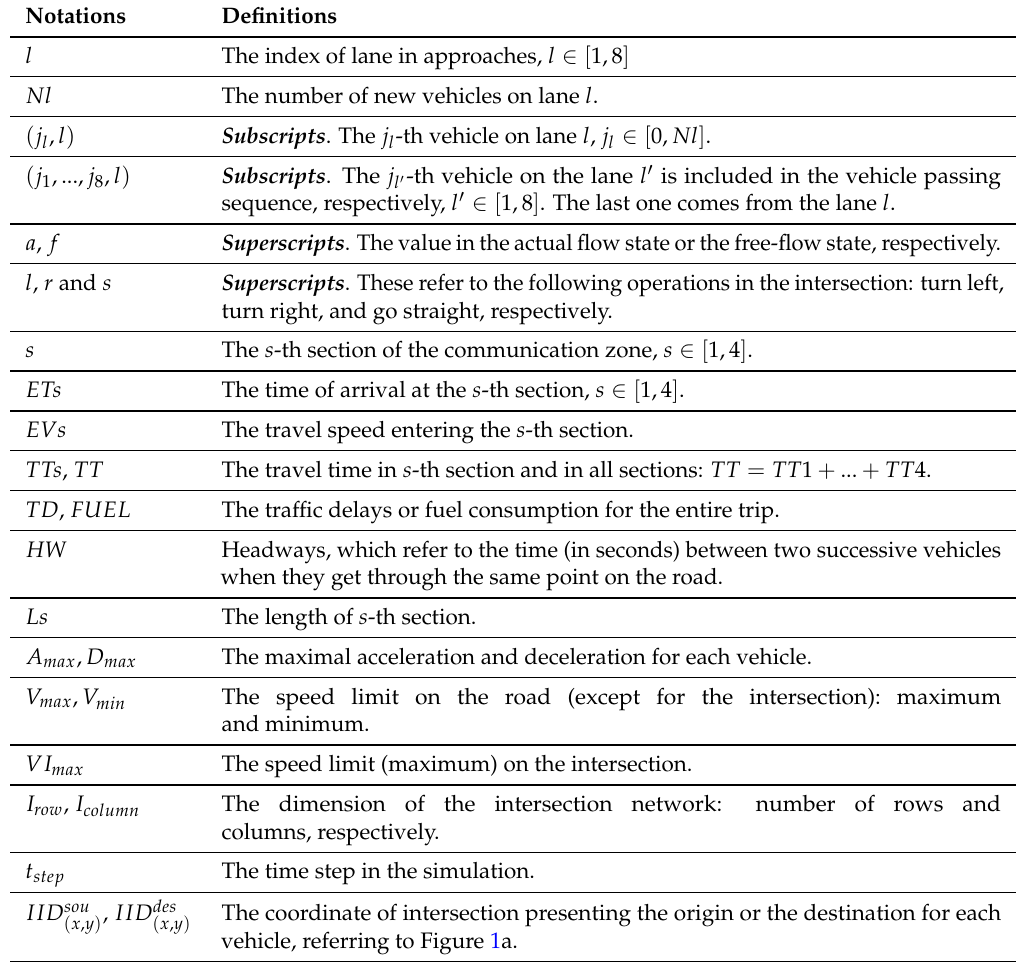
Table 2. Definitions of the